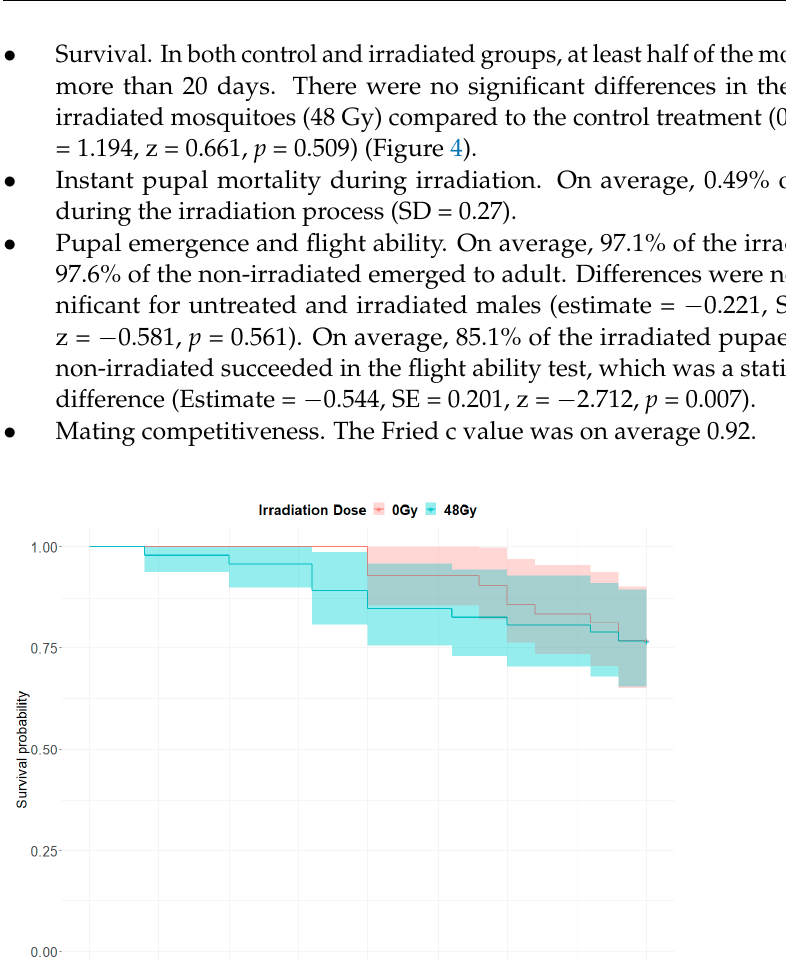
Table 1. Parameter estimates for the model relating hatching rate to irradiation dose. Egg Hatching Estimate Std. Error z Value p -Value Intercept 1.694 0.033 50.40 <0.0001 Dose (Gy) − 0.133